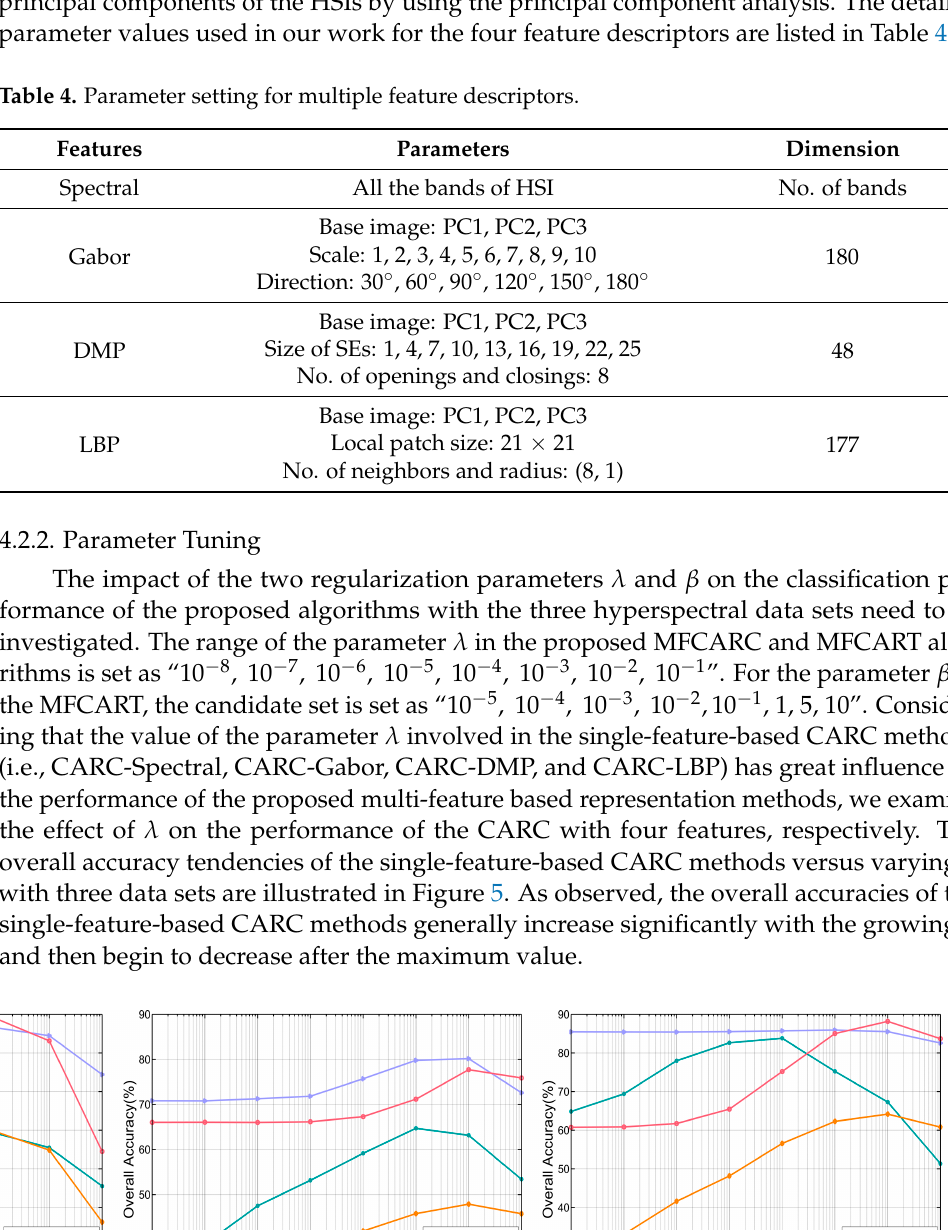
Figure 6. Classification accuracy versus varying β for the proposed MFCART method. ( a ) Indian Pines. ( b ) Pavia Univer ‐ sity. ( c ). Salinas. Table 5. Optimal parameters for the proposed methods. Indian Pines